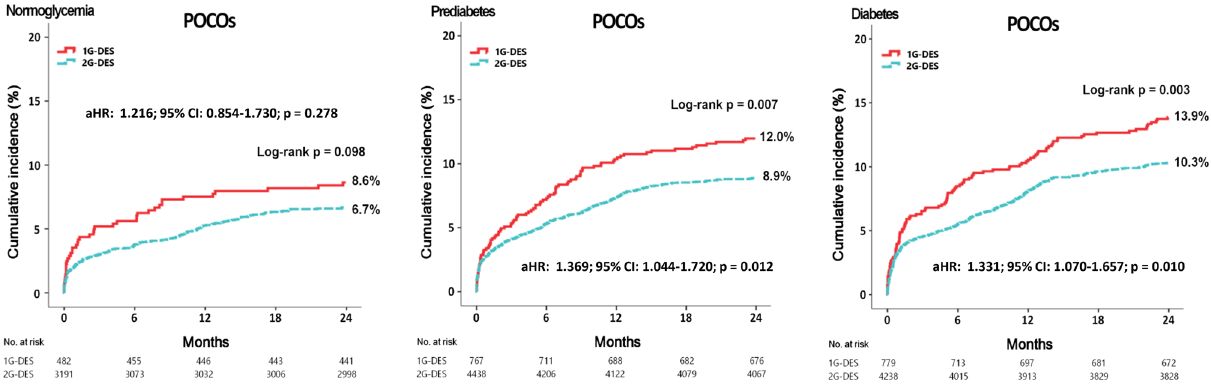
Figure 1. Kaplan–Meier analysis of the incidence of